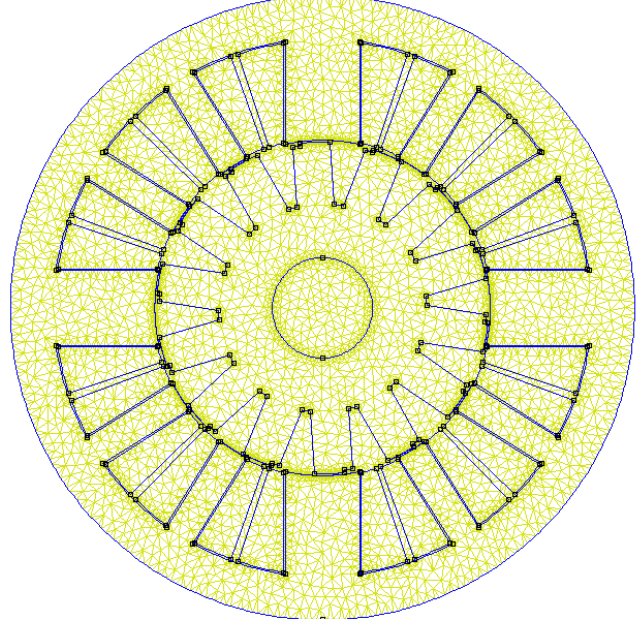
Figure 12. Finite element model of the stepped rotor BLSRM.